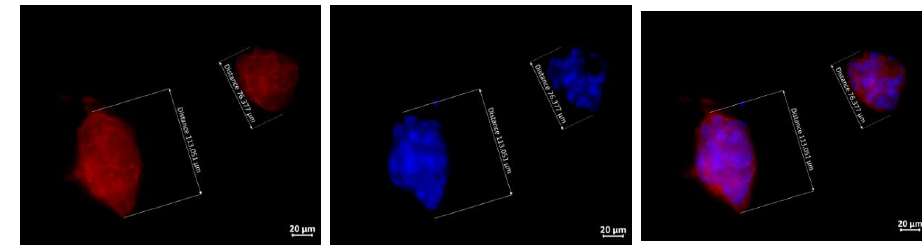
Figure 6. Multipotent mesenchymal stem cell spheroids formed on different scaffolds at three days after seeding (µm). The fibrillar actin of the cytoskeleton was stained with rhodamine fluorochrome; nuclei were stained with DAPI. Combined two-channel image, magnification ×40.